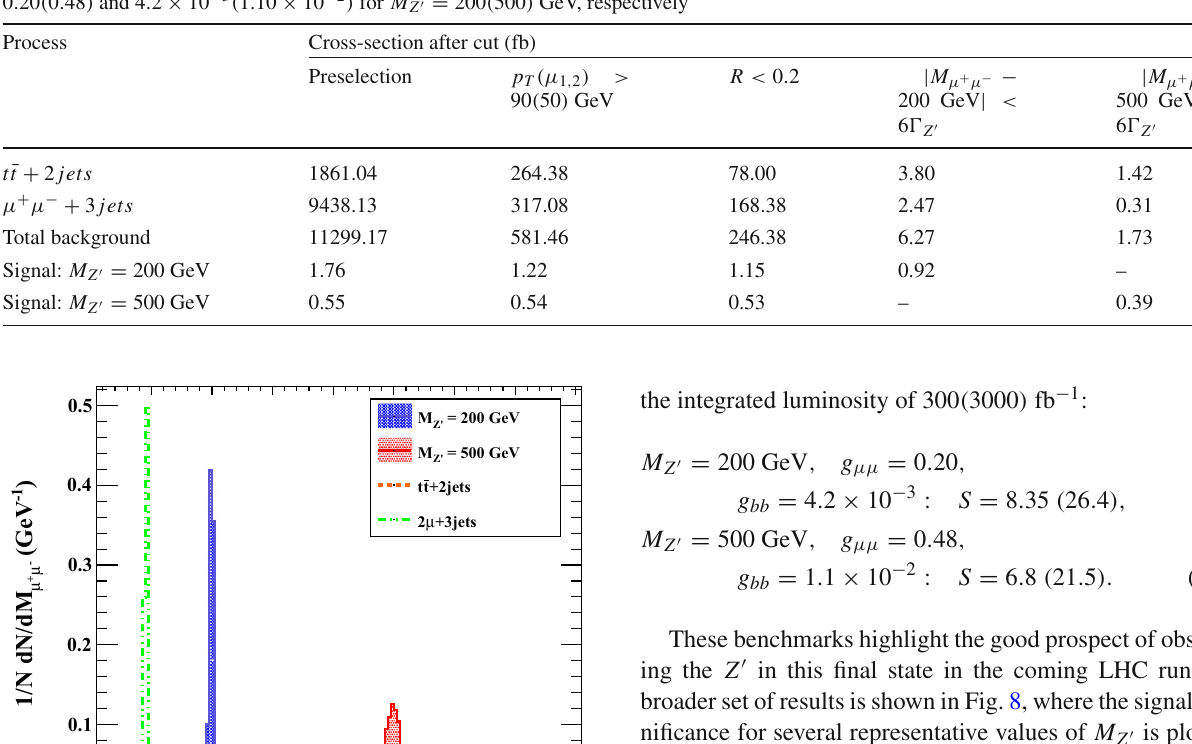
√ s = 14 TeV. The values of g μμ and g bb are